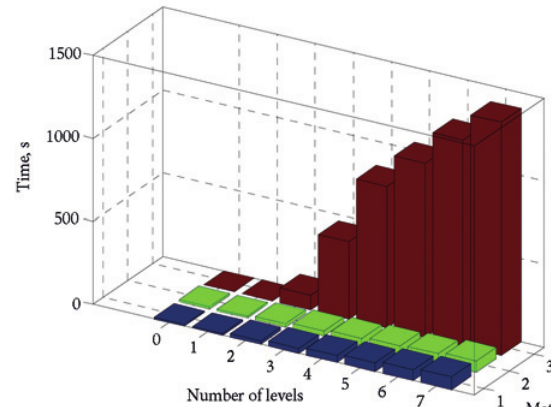
Fig. 11. RMSE (Latitude) changing by increasing distance of initial value of point’s height from real value of point’s height